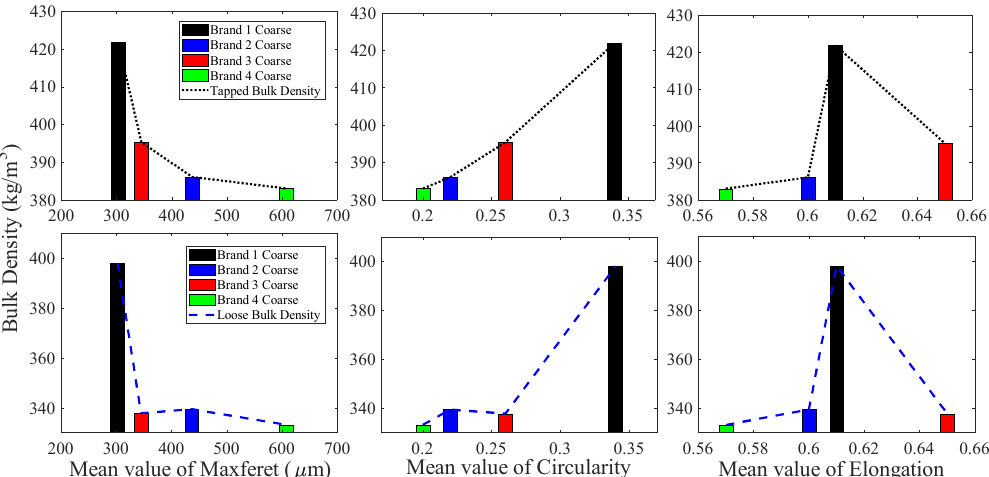
Figure 9. Tapped and loose bulk density from four different brands of instant whole milk powder samples versus mean values of shape factors for coarse particles.